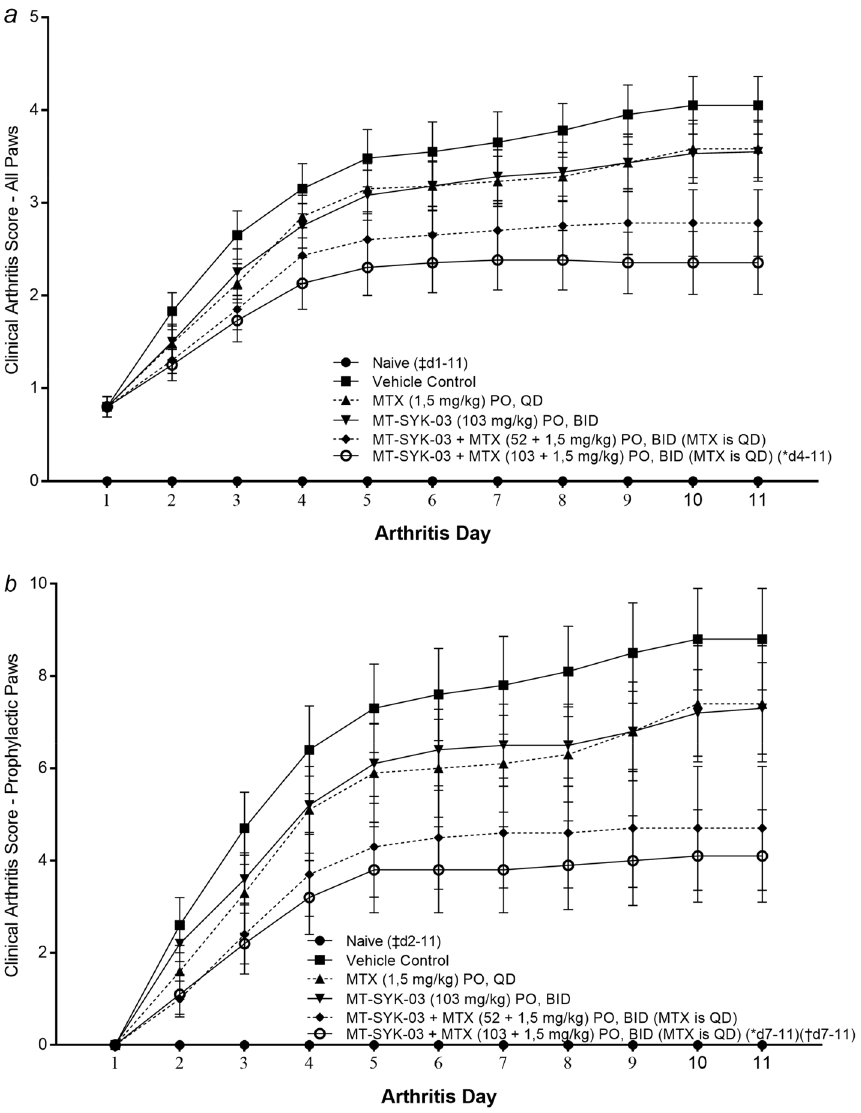
Figure 8. Effects of oral administration of MT-SYK-03 alone or in combination with MTX in murine CIA model. The clinical arthritis score, mean ± SE (n = 10 for vehicle and treatment groups and 4 for naive group) for ( a ) all paws and ( b ) non-involved (prophylactic) paws for six groups of animals: Scores measured severity of inflammation from 0 (no inflammation) to 5 (severe inflammation). *p < 0.05 ANOVA to Vehicle